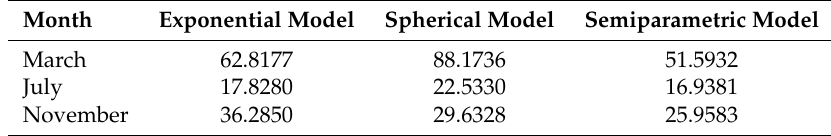
Table 3. The weighted sum squared errors of three different semivariograms for March, July and November in Fold